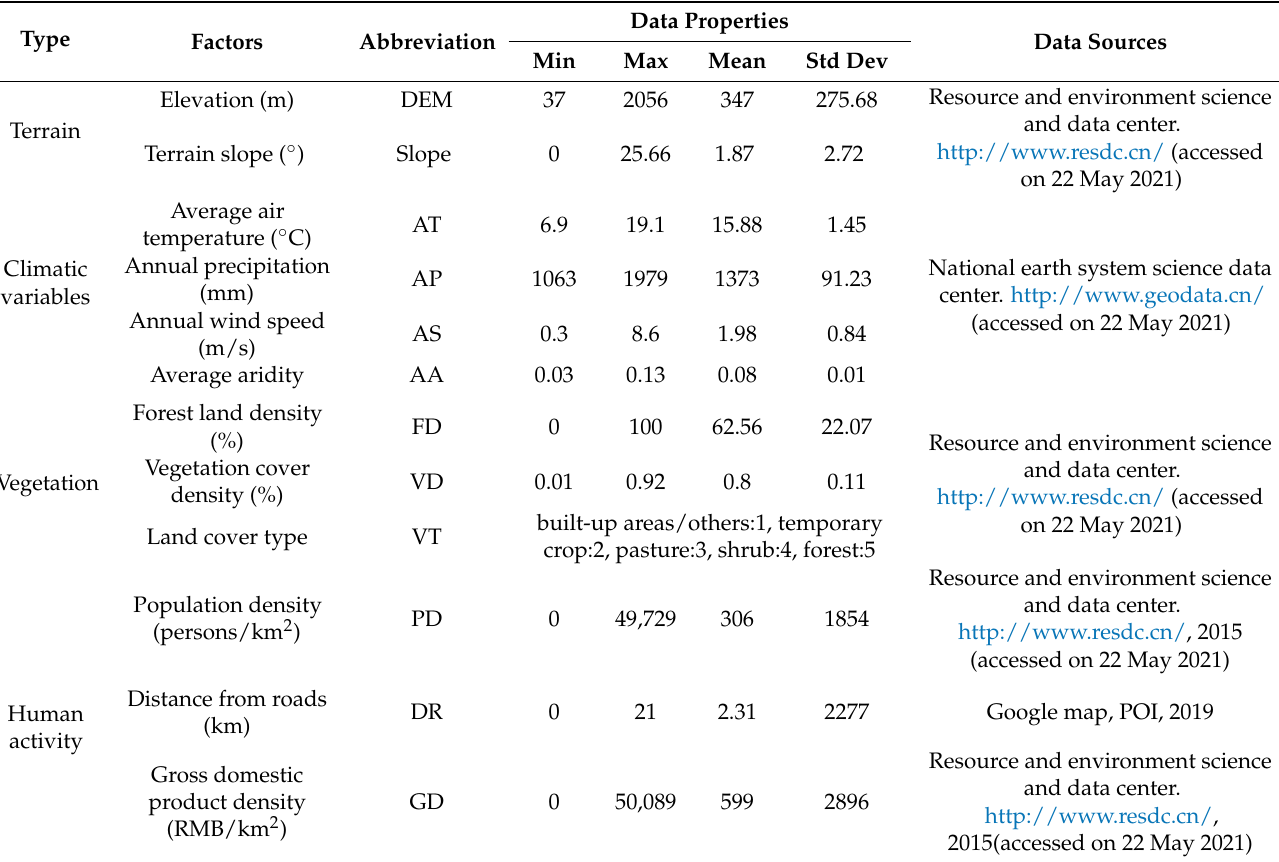
Table 1. The factors used in wildfire classification and the description of wildfire